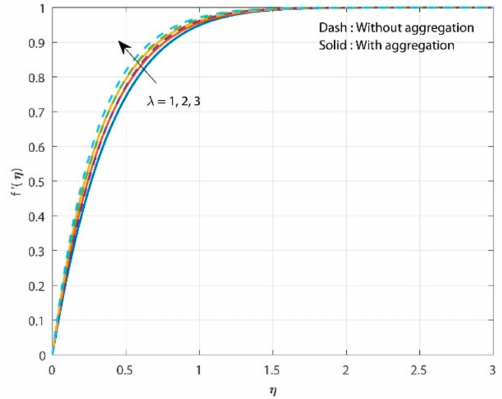
Figure 6. Influence of rotation parameter on f (cid:48)